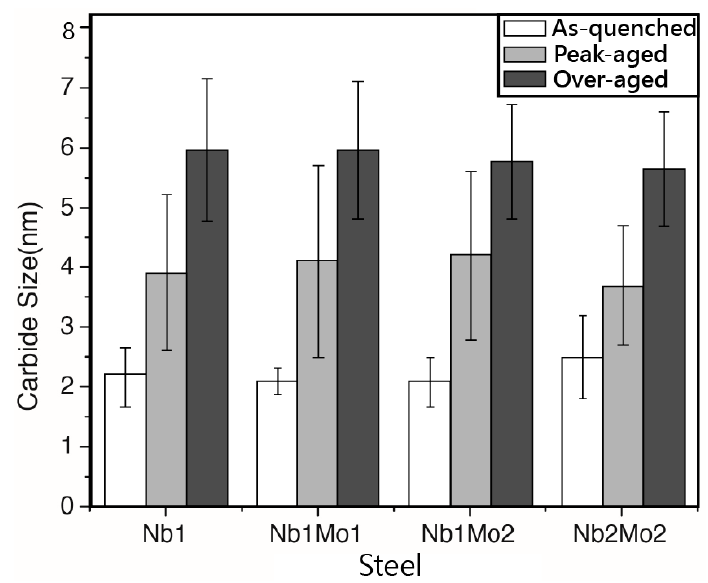
Figure 9. The average carbide size in as-quenched, peak-aged, and over-aged conditions for the four studied steels.